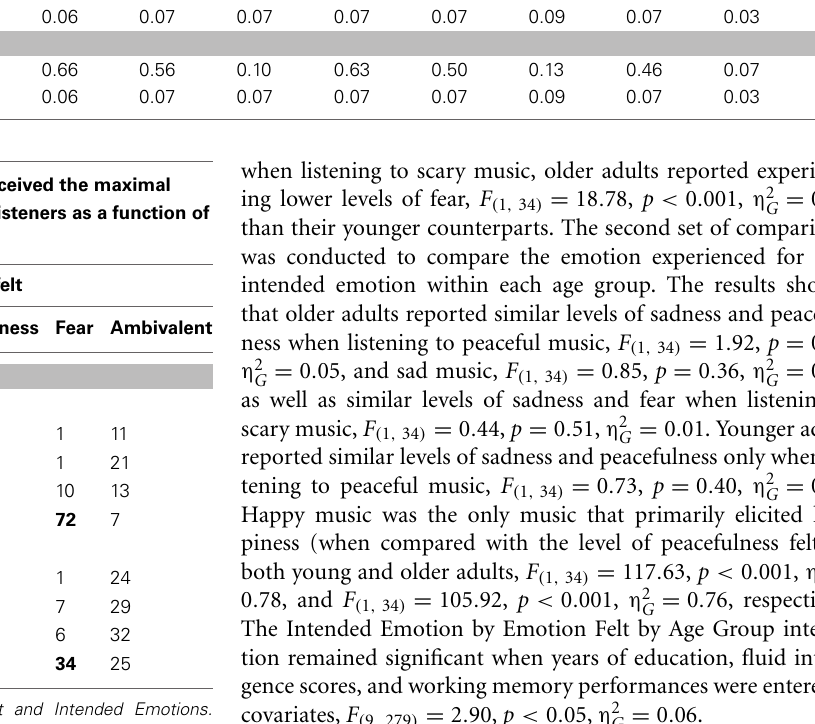
Bold indicates the match between Emotion Felt and Intended